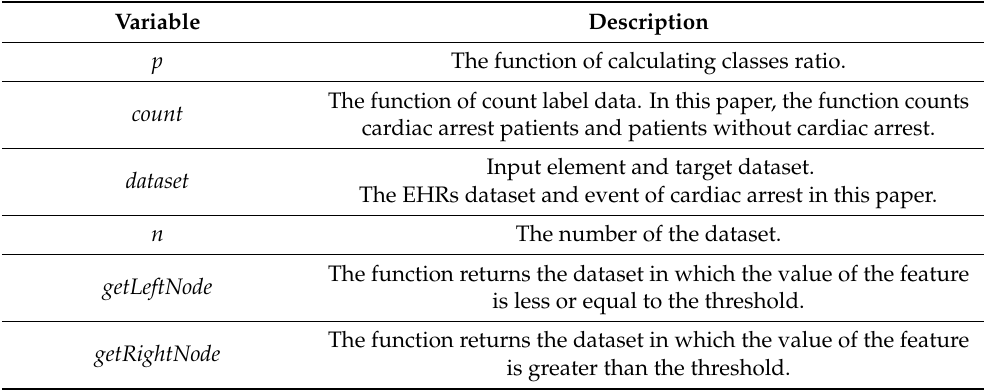
Table 3. Variables of the decision